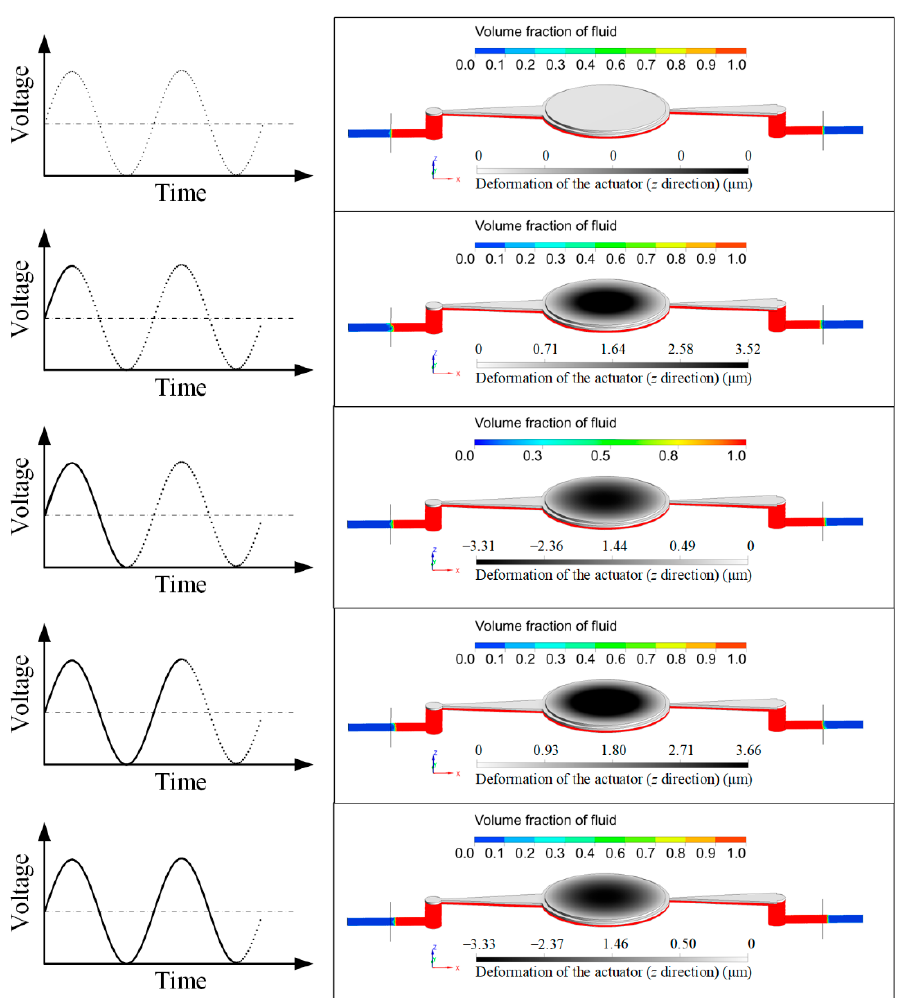
Figure 3. The pumping statuses at different times.